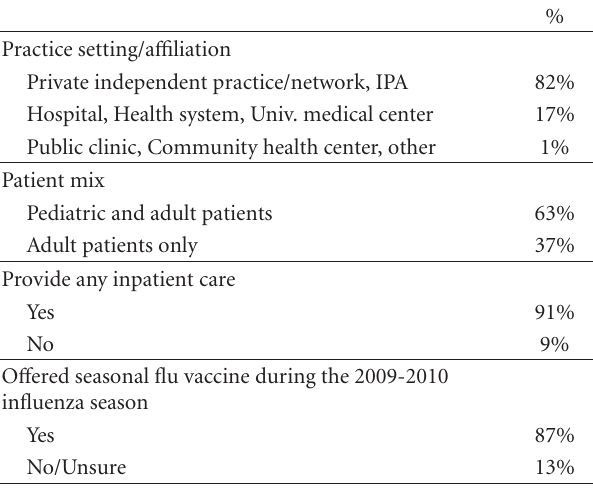
Table 1: Respondent characteristics ( N =